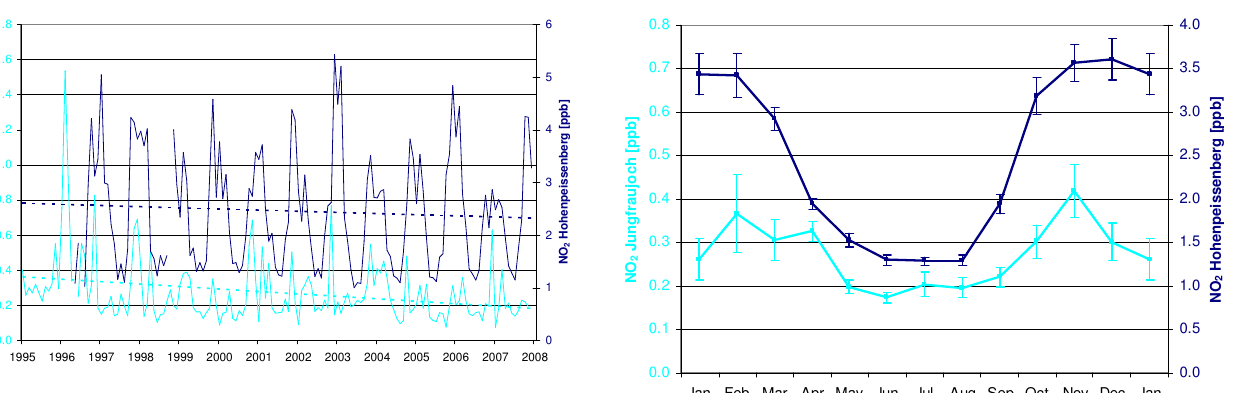
Fig. 11. NO 2 time series since 1995 at the respective “DACH” sites, dark blue: HPB (right axis); light blue: JFJ (left axis). Monthly Figure 11. NO 2 time series since 1995 at the respective „DACH“-sites, dark blue: HPB (right 3 mean mixing ratios (solid) and linear trend (dashed). Figure 12. NO 2 mean annual variation at the „DACH“ sites; dark blue: HPB; light blue: JFJ. 2 axis); light blue: JFJ (left axis). Monthly mean mixing ratios (solid) and linear trend (dashed). 4